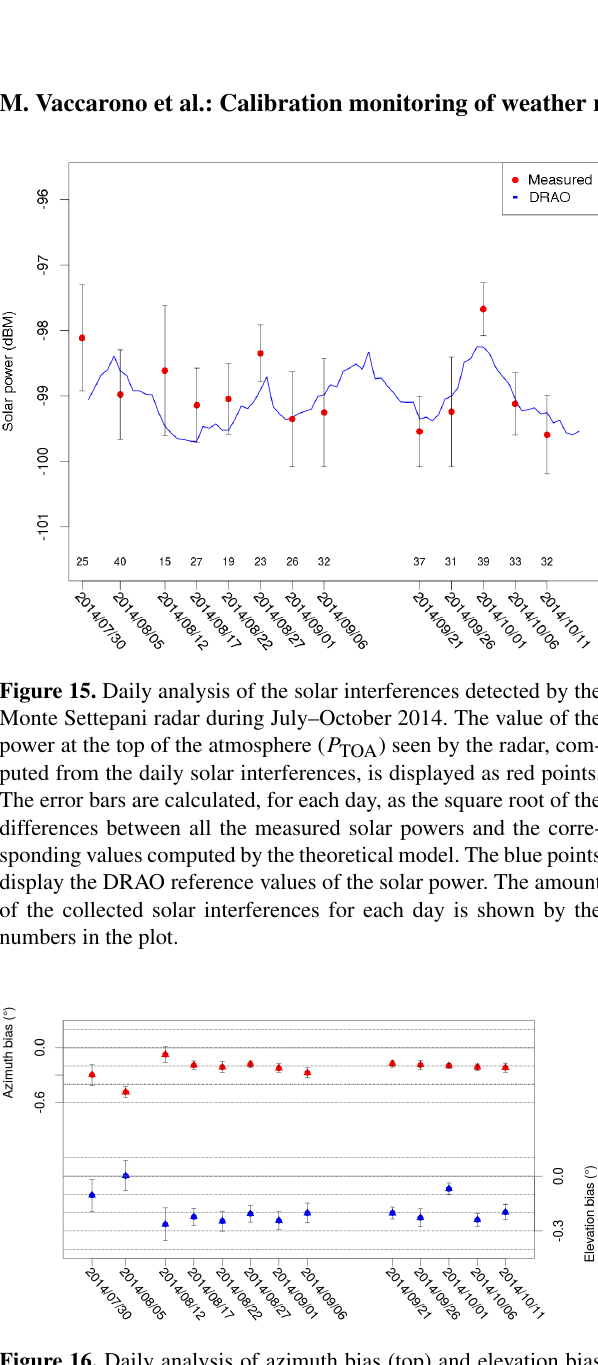
Figure 16. Daily analysis of azimuth bias (top) and elevation bias (bottom) of the Monte Settepani radar during July–October 2014.